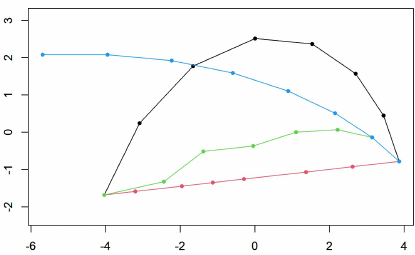
Figure 12. PC1-PC2 scatterplot of the PCA perfomed on the four set of shapes resulting from the bending+size case. PC1 explains 79.36% of total variance, while PC2 explains 17.54%. Black refers to the optimized shapes, red to the linearized, green to the original shapes and cyan to the shooted shapes. Table 4. Values of the energies for the non-affine case of bending and scaling; d u represents the affine component of the Γ -energy, d b the non-affine component, and d tot the total Γ -energy. LINEAR GEODESIC